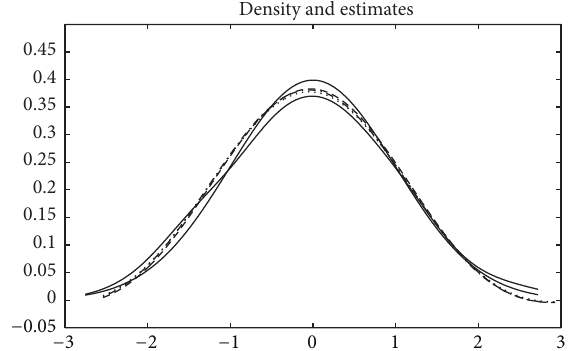
Figure 2: Estimates of normal density through normal noise for 𝑛 = 400 . The thick solid line is the true density, the thin solid line and the dashed line are the kernel estimator and the SC estimator when 𝑓 𝜀 is known, respectively, and the dot-dashed line and the dotted line are the SC estimators when the noise sample sizes 𝑀 = 50 and 𝑀 = 10 , respectively.